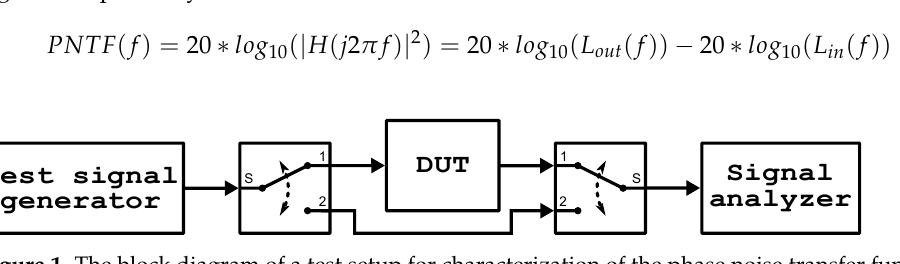
Figure 1. The block diagram of a test setup for characterization of the phase noise transfer